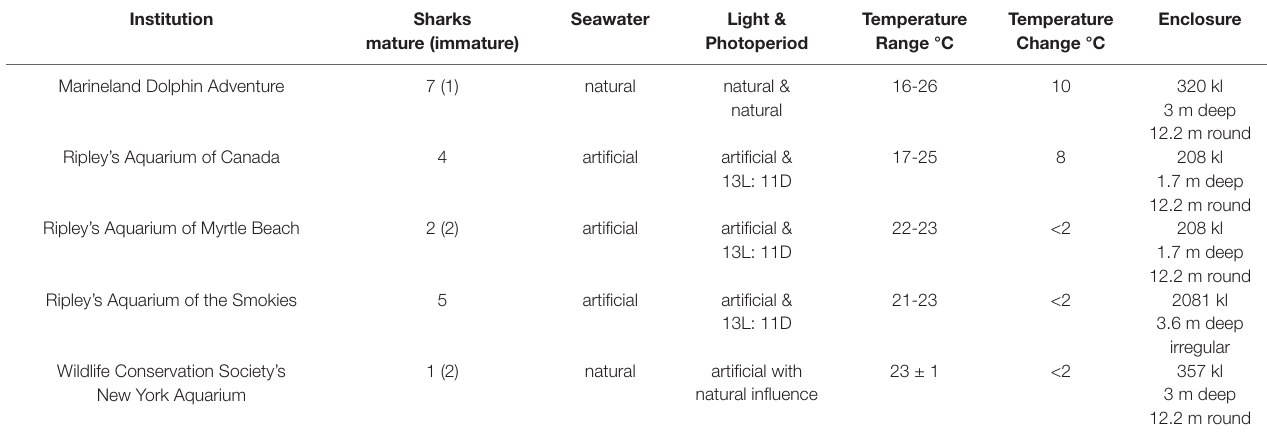
TABLE 1 | Environmental characteristics for aquarium sand tiger sharks Carcharias taurus